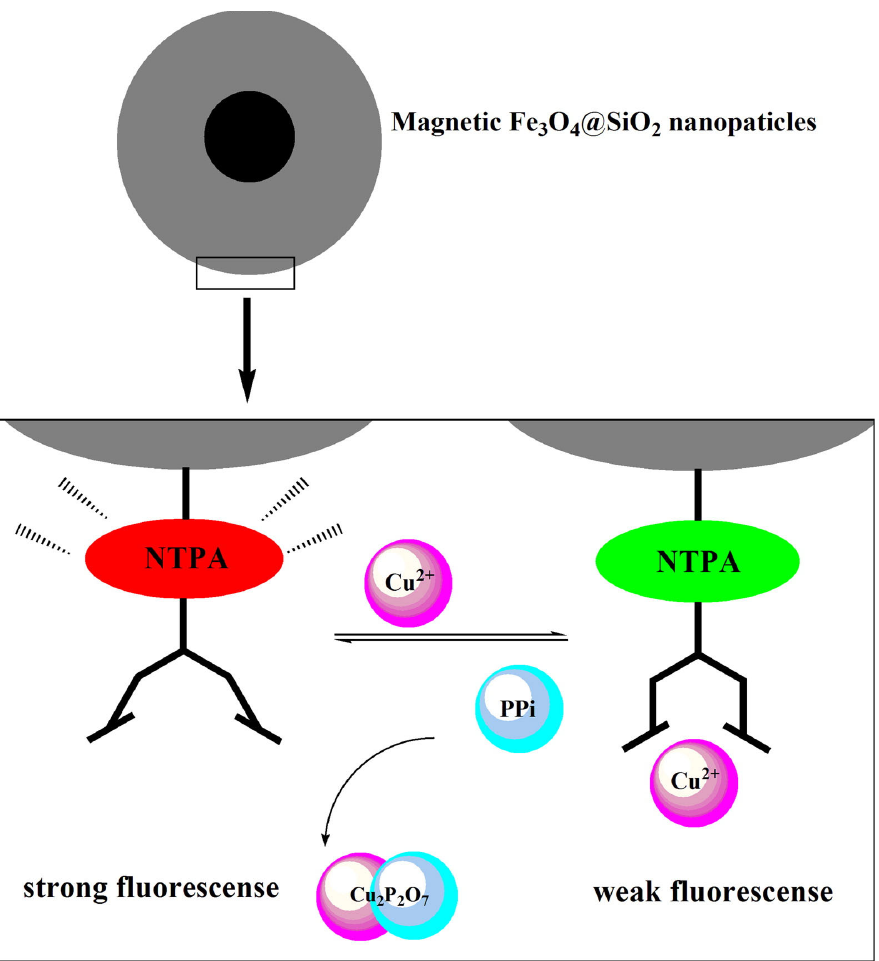
Figure 15. Proposed mechanism of fluorescent chromophore NTPA for assay of Cu 2+ and PPi (reprinted with permission from [150]).